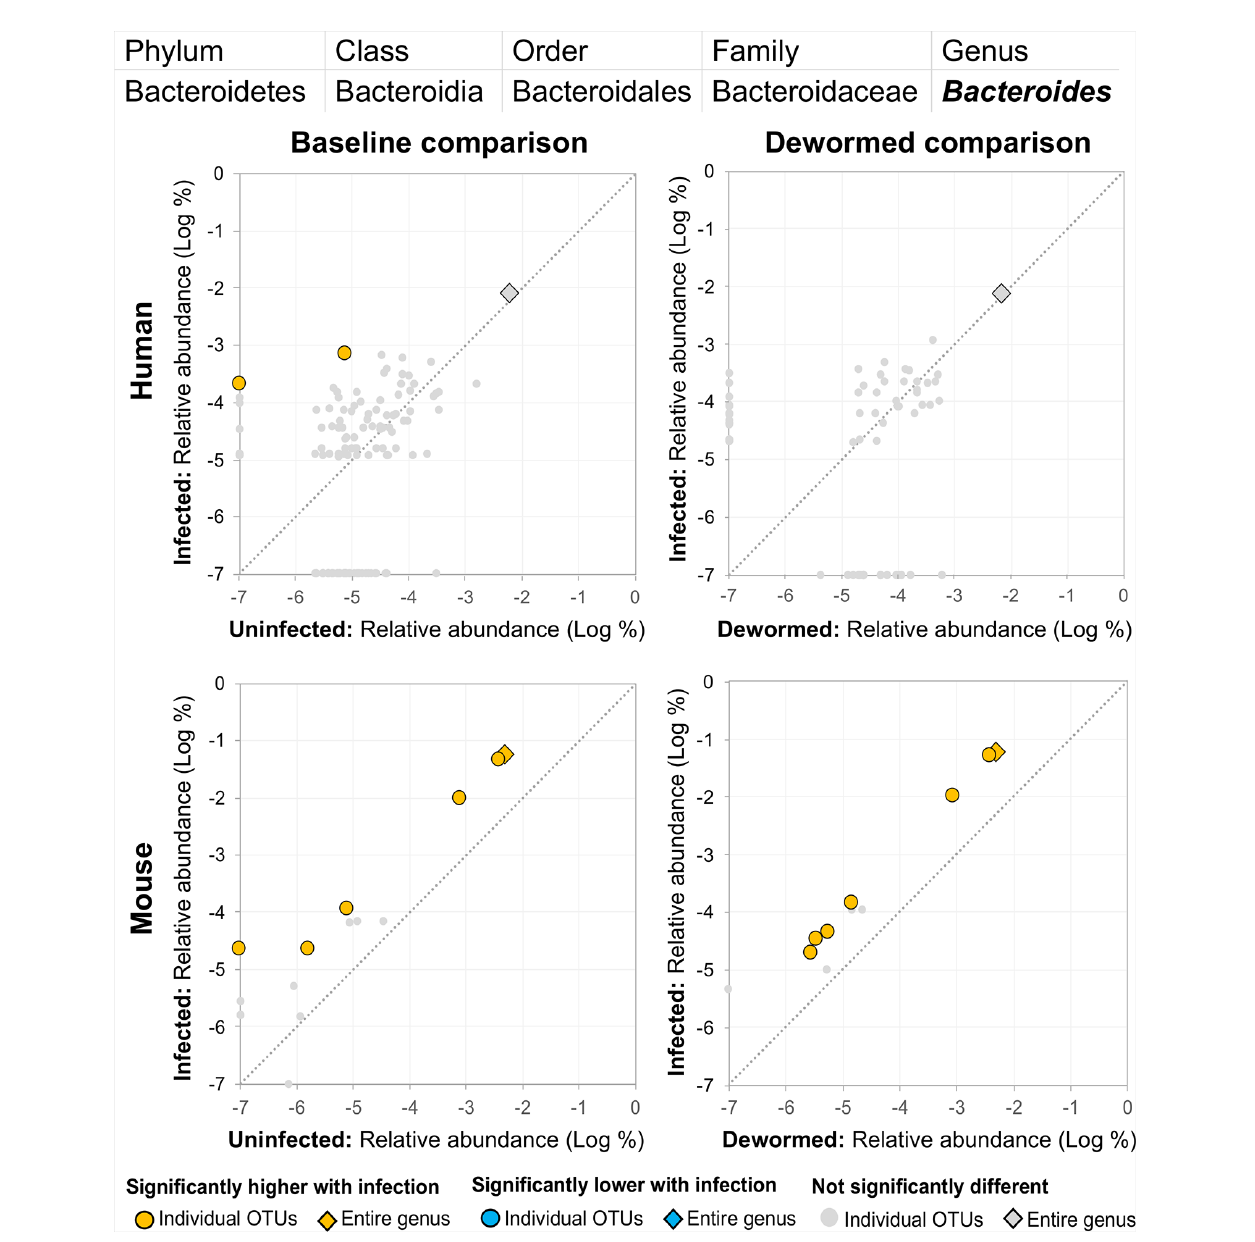
FIGURE 8 | The relative abundance (%) of all Bacteroides (genus) OTUs in each differential comparison among samples from whipworm-infected and uninfected humans and mice. Signi fi cant differentially abundant OTUs in each comparison (as identi fi ed by LEfSe) are colored in orange (higher with infection) and blue (lower with infection). The sum of all OTUs in the genus is represented with a diamond symbol. This is one of three genera with at least one OTU signi fi cantly higher in infection in three of four